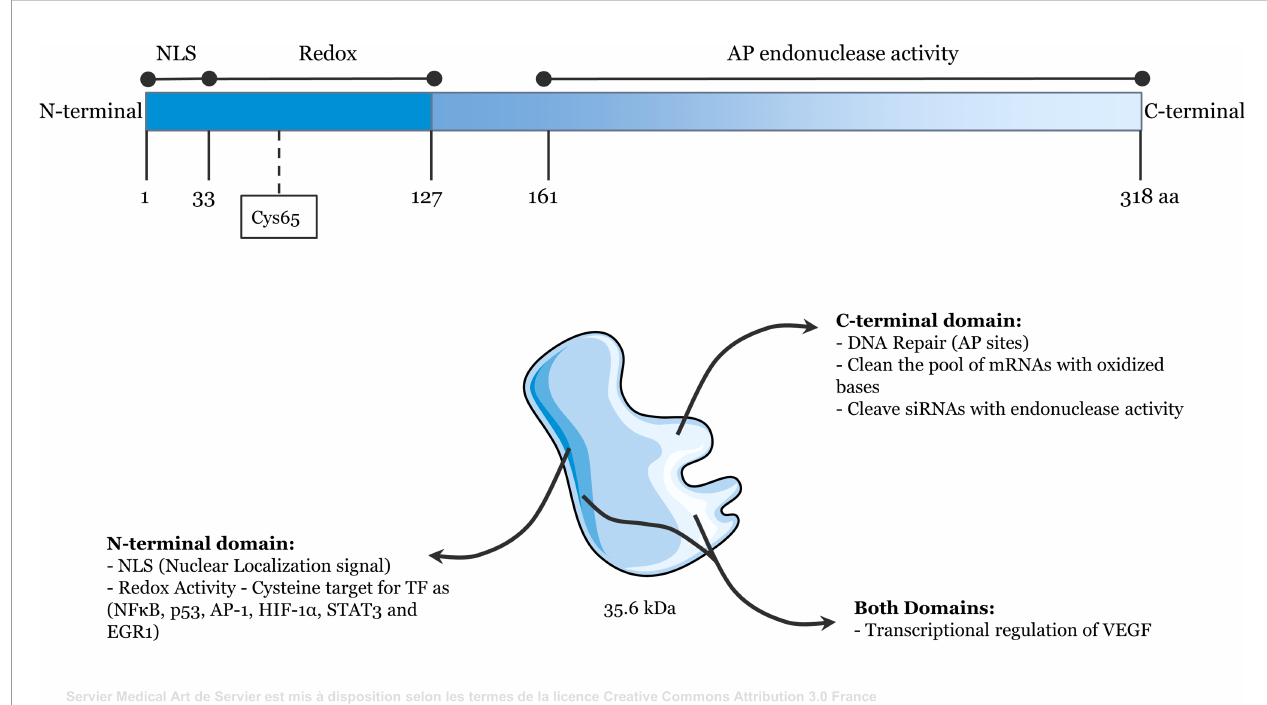
FIGURE 1 | Representative scheme of the functional domains of Apurinic/apyrimidinic endonuclease 1/redox effector factor 1 (APE1/Ref-1). The N-terminal domain (amino acids 1 to 127) contains redox activity and the nuclear localization signal. The C-terminal domain (amino acids 161 to 318) contains apurinic/apyrimidinic endonuclease activity. Both domains may be involved in the transcriptional regulation of some genes, such as